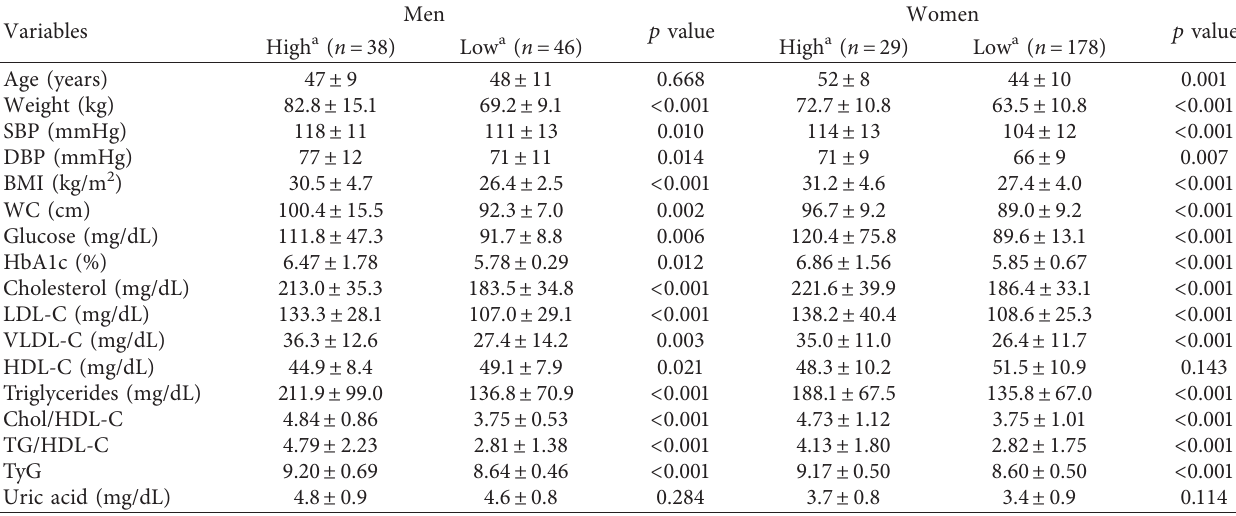
Table 2: Cardiometabolic variables of participants by lifetime cardiovascular risk and